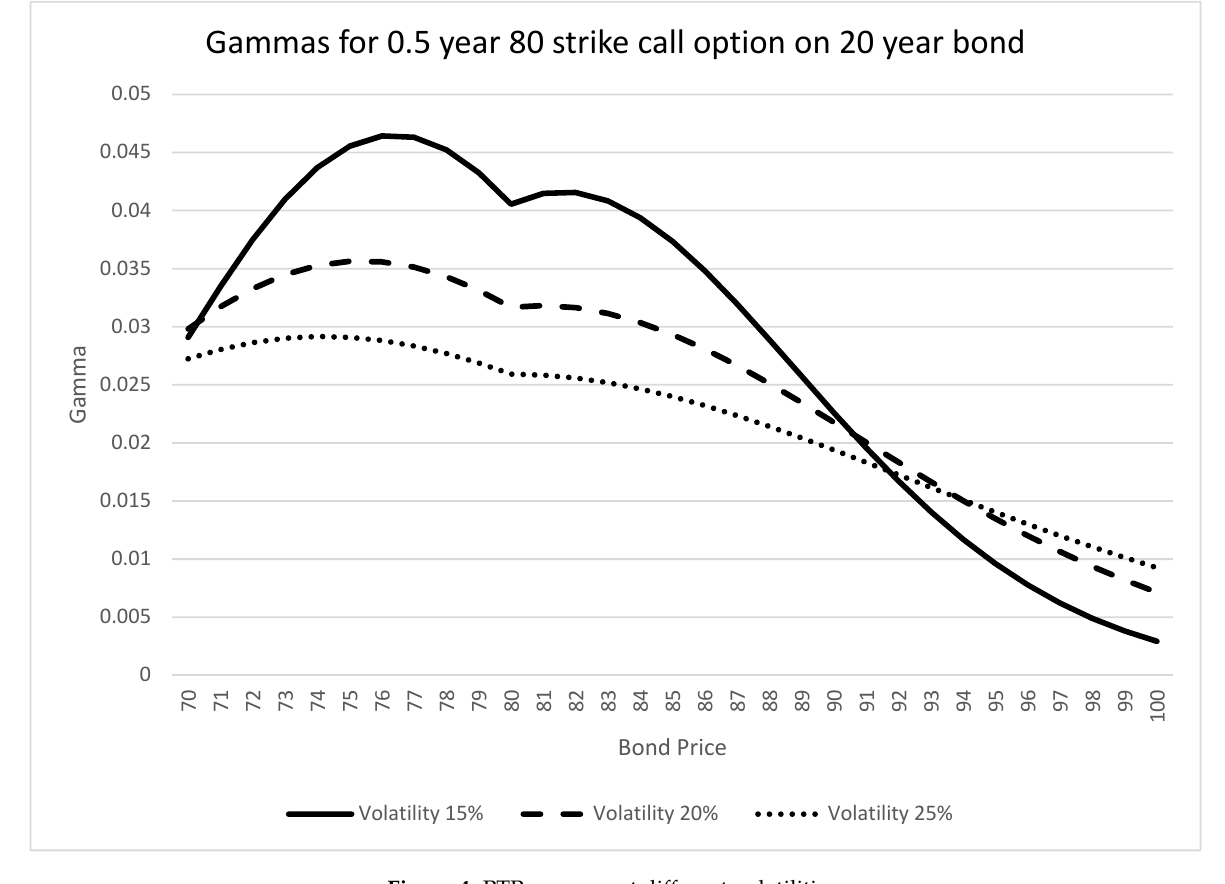
Figure 4. PTP gammas at different volatilities.